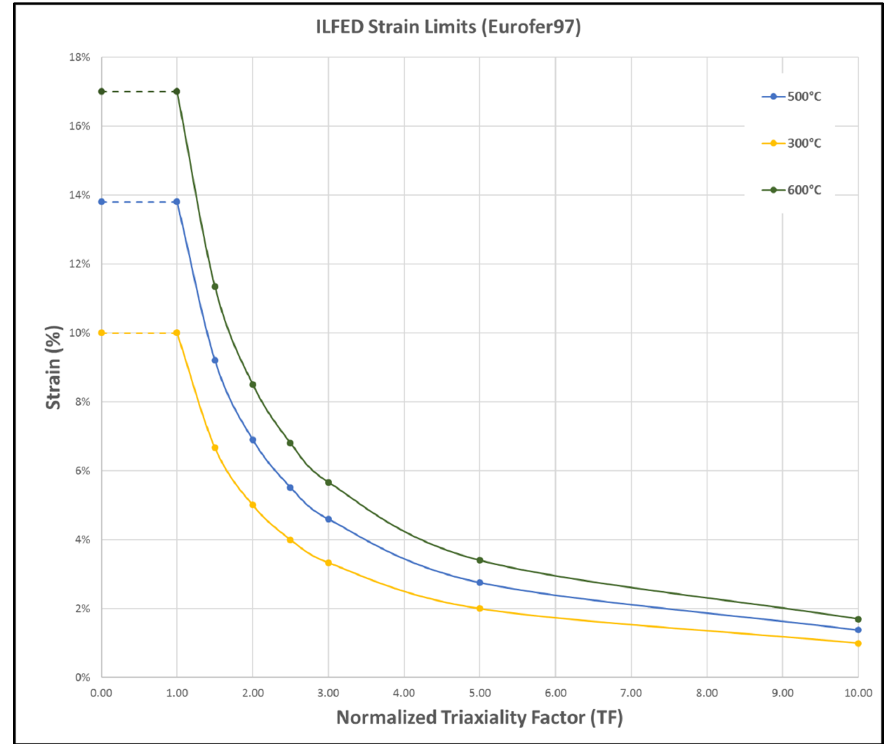
Figure 6. ILFED strain limits with respect to the triaxiality factor.